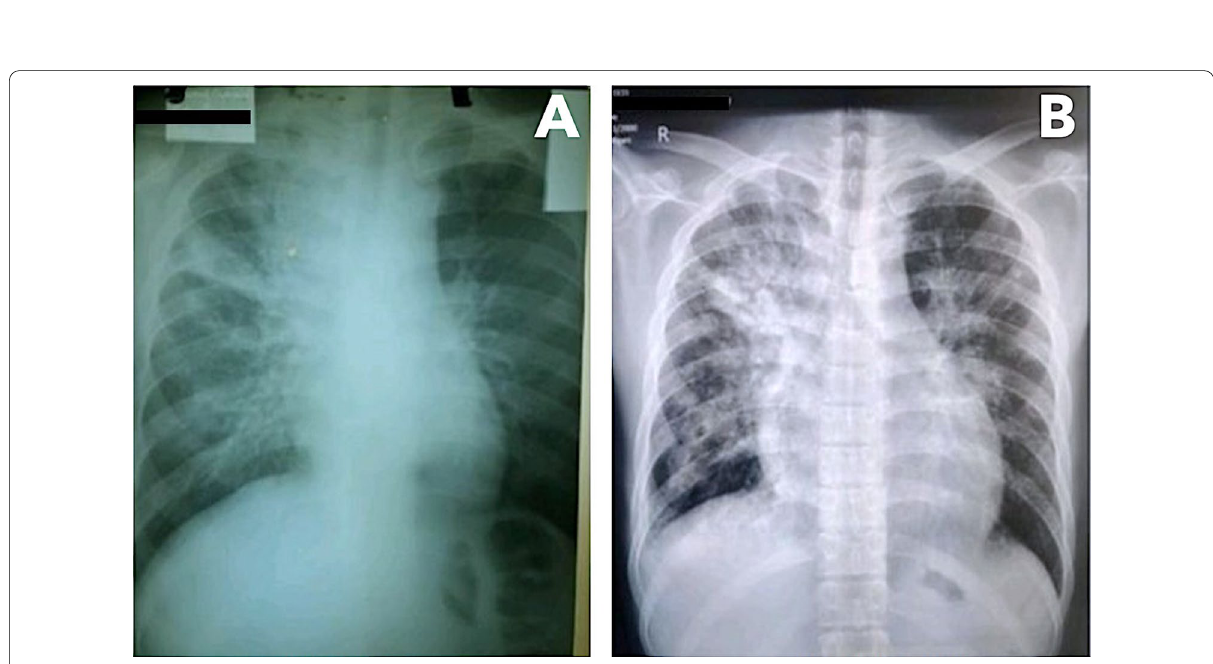
Fig. 2 Chest radiographs taken 5 months prior to admission during initial diagnosis of tuberculosis ( A ) and taken on admission ( B